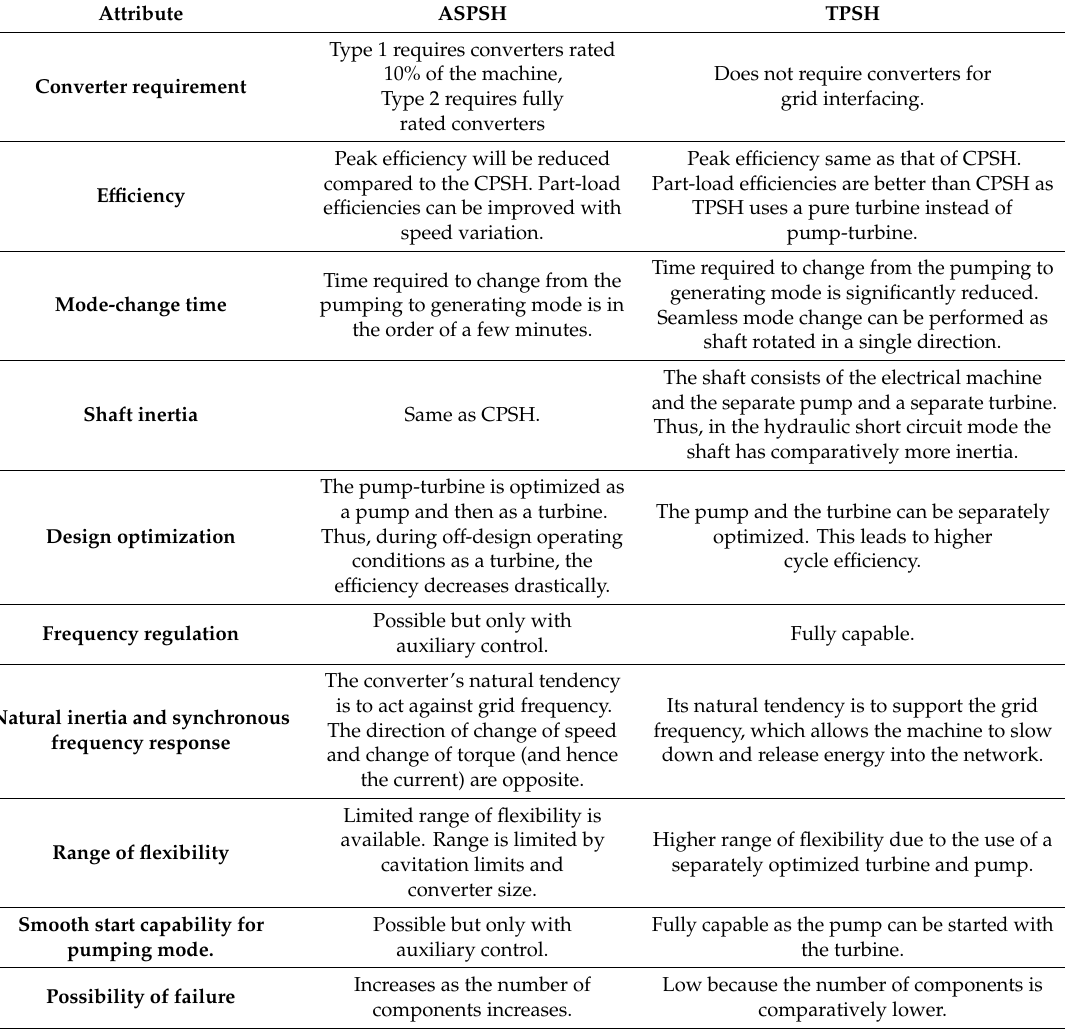
Table 1. Comparison of adjustable speed PSH (ASPSH) and TPSH with respect to conventional PSH